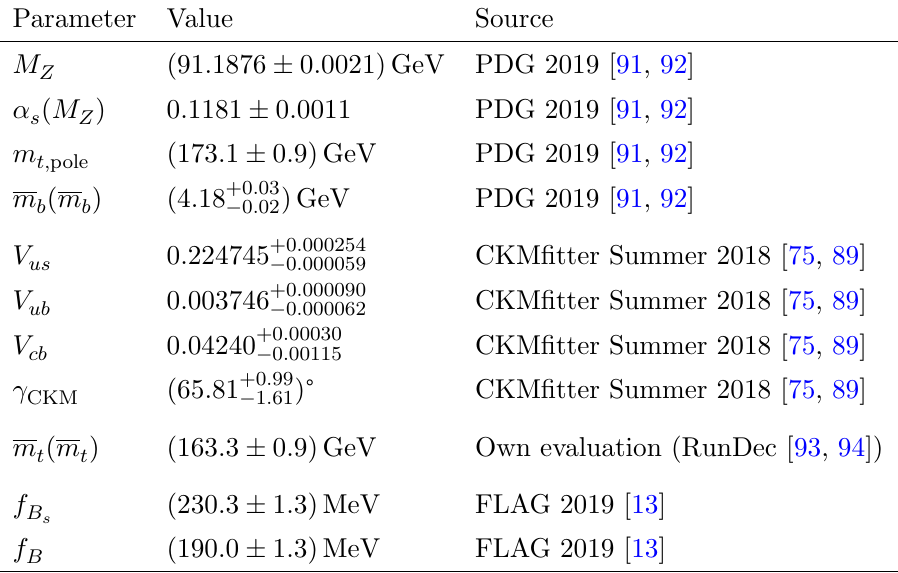
and (cid:1) M s d